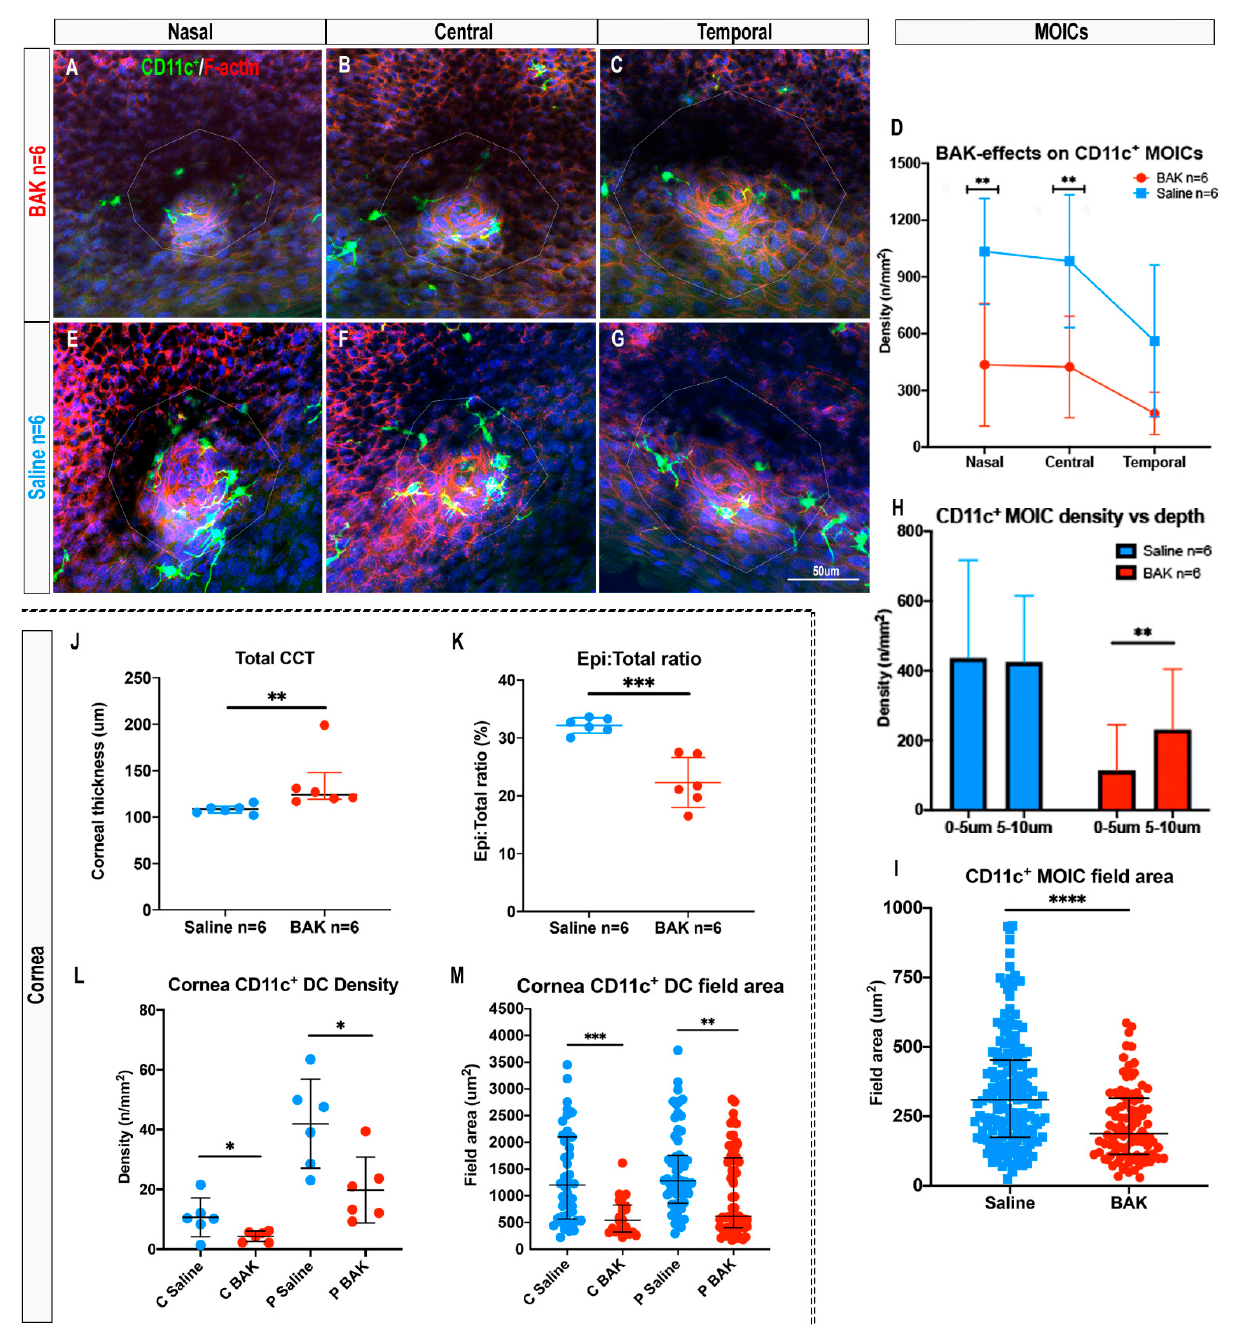
Figure 5. BAK- vs. saline-treated eyes. Confocal microscopy images of CD11c + MOICs around MGOs in BAK-treated CD11c-eYFP mouse eyes ( A – C ) and saline-treated controls ( E – G ). ( D ) Graph represents the effect of BAK on CD11c + MOICs in each region, and the distribution of CD11c + MOICs from 0–5 μ m and 5–10 μ m depths in saline controls vs. BAK-treated eyes ( H ), mean ± SD. ( I ) CD11c + MOIC field area in saline controls vs. BAK-treated eyes, median (inter-quartile-range). ( J ) Total central corneal thickness (CCT) between saline controls and BAK-treated eyes, median (inter- quartile-range). ( K ) Corneal epithelial thickness: total central corneal thickness ratio (%) between saline controls and BAK-treated eyes. ( L ) Corneal CD11c + DC density in the central and peripheral corneal regions in saline controls vs. BAK-treated eyes. ( M ) Corneal CD11c + DC morphology, meas- ured by field area, in the central and peripheral corneal regions comparing saline controls vs. BAK-